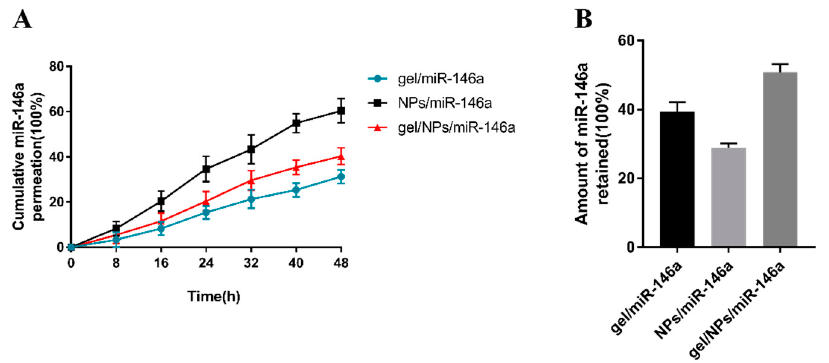
Figure 3. ( A ) Cumulative miR-146a curve of permeation in the nasal mucosa from the NPs/miR-146a, gel/miR-146a, and binary gel/NPs/miR-146a formulations. ( B ) Amount of miR-146a retained in the nasal mucosa after 48 h of application of the different formulations.